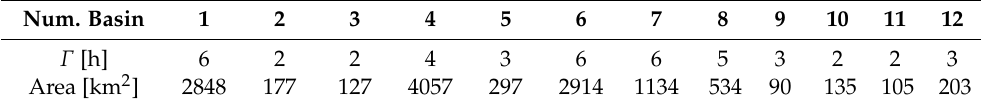
Table 3. Values of Γ , for which the lowest values of the selected criteria were reached. Num.